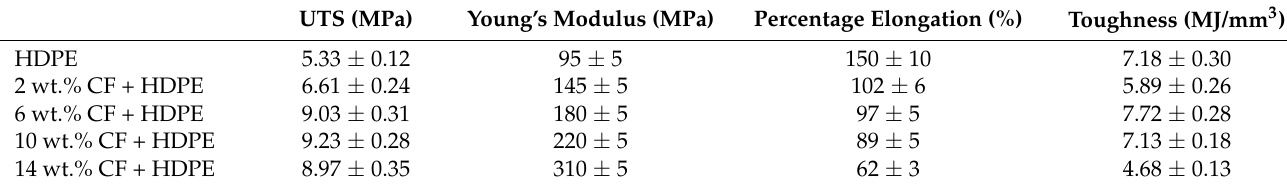
Table 3. A summary of tensile